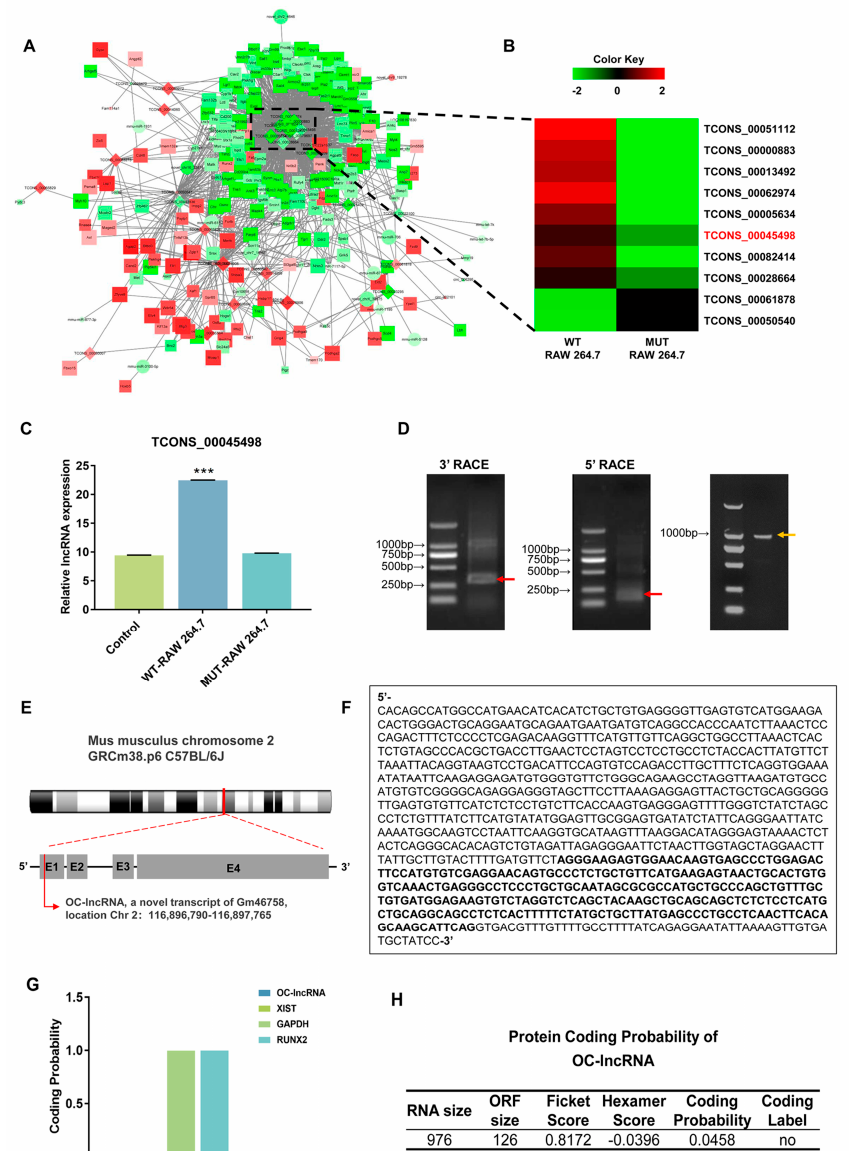
Figure 2. Identification of a novel lncRNA transcript in CCD. ( A ) The regulatory network of dif- ferentially expressed mRNAs (rectangles), lncRNAs (rhombuses), microRNAs (circles), and circR- NAs (triangles). ( B ) The heatmap of 10 core regulatory lncRNAs. ( C ) Expression validation of TCONS_00045498 by real-time PCR with RANKL induction for 3 days. ( D ) The gel results of the 3 (cid:48) /5 (cid:48) RACE products (red arrows) and the whole sequence (yellow arrow). ( E ) Schematic of OC-lncRNA. ( F ) The complete nucleic acid sequence of OC-lncRNA. Identical sequence among OC-lncRNA and three transcripts of Gm46758 is indicated in bold. ( G ) Coding-potential assessment of OC-lncRNA by CPAT analysis. ( H ) OC-lncRNA displayed no coding probability. LncRNA XIST was used as a representative non-coding gene. GAPDH and RUNX2 were used as representative coding genes. Error bars represent SD. *** p <